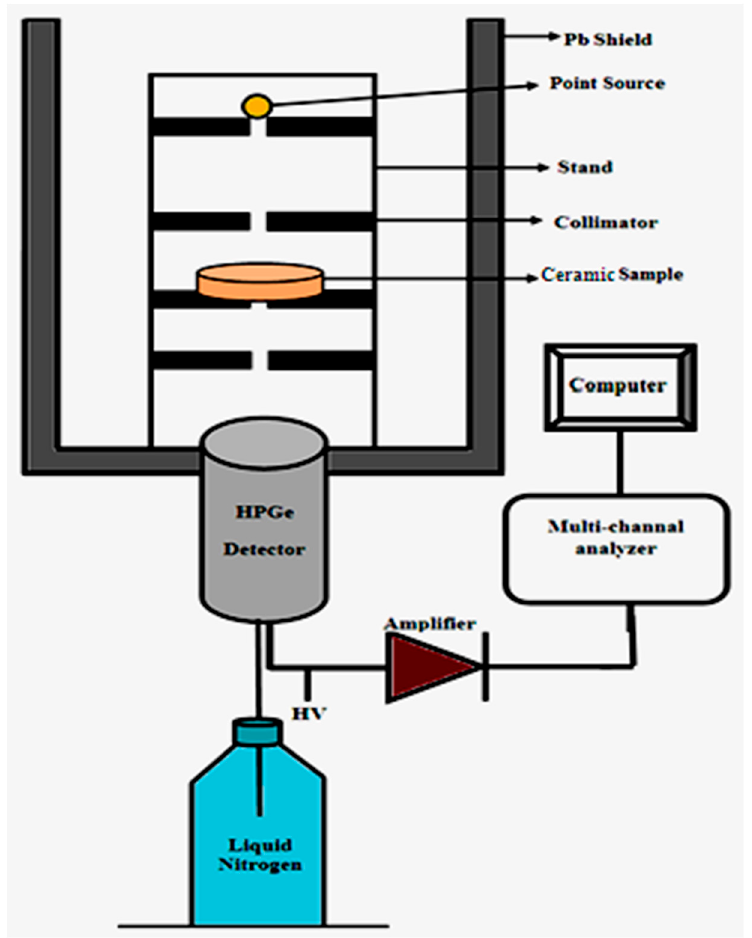
Figure 2. The geometry of the experimental setup.